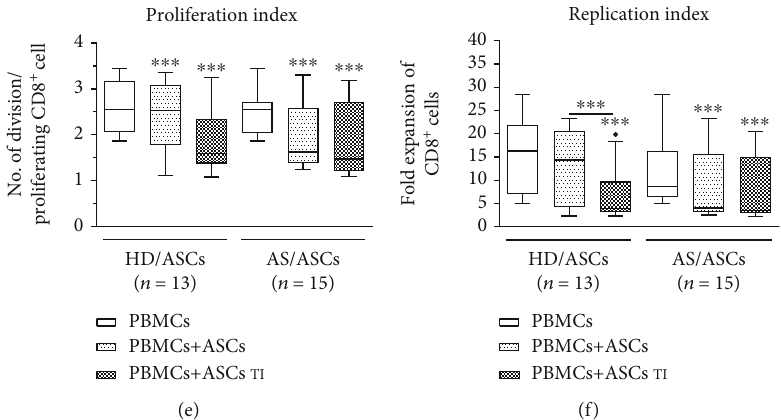
Figure 1: Inhibition of T cell proliferation by ASCs of healthy donors (HD) and AS patients. Peripheral blood mononuclear cells (PBMCs) obtained from 9 healthy donors (HD) were stimulated with PHA and cultured alone (control) or cocultured for 5 days with either untreated or TNF +IFN γ - (TI-) stimulated ASCs from 5 HD (HD/ASCs) or 10 AS patients (AS/ASCs). The proliferation of CD4 + (a – c) and CD8 + (d – f) T cells was analyzed by fl ow cytometry. Data are the results of the indicated number of experiments ( n ). (a, d) Lines between points identify cultures containing the same combination of ASCs and PBMCs. (b – f) Results are expressed as the median (horizontal line) with interquartile range (IQR, box), lower and upper whiskers (data within 3/2 × IQR) and outliers (points) (Tukey ’ s box). ∗ P = 0 : 05 – 0 : 01 , ∗∗ P = 0 : 01 ‐ 0 : 001 , and ∗∗∗ P = 0 : 001 ‐ 0 : 0001 for intragroup comparisons (cell cocultures vs. control separate cultures and as indicated). The intergroup (HD vs. AS) di ff erences were statistically insigni fi